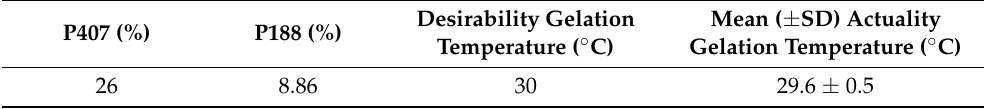
Table 4. The predicted and actual value of optimized desired